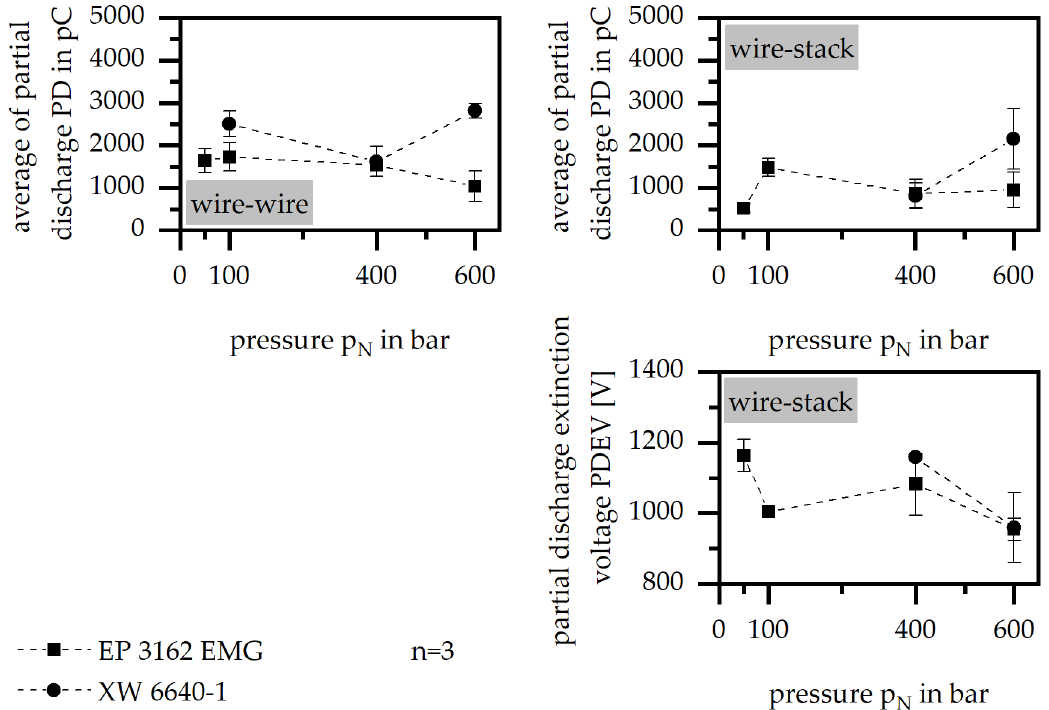
Figure 6. Average of partial discharge (PD) and partial discharge extinction voltage (PDEV), relative to the holding pressure in the insulation system of wire to wire and wire to stack.